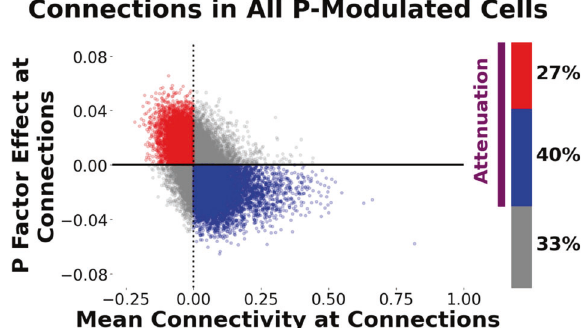
Fig. 4 Quadrant analysis demonstrating attenuating effects of the P factor on neurotypical functional-connectivity patterns. In the main NCA analysis, we identi fi ed 28 cells (i.e., sets of connections linking pairs of large-scale networks) that were signi fi cantly associated with the P factor. In a follow-up quadrant analysis, we placed these connections in one of four quadrants according to directionality of mean connectivity ( x axis) and directionality of P factor effects ( y axis); in the fi gure, each dot represents one connection. We found 67% of connections reside in quadrants corresponding to attenuating effects, i.e., quadrant 2 shown in red (negative mean connectivity, positive P factor effect) and quadrant 4 shown in blue (positive mean connectivity, negative P factor effect). Non-parametric permutation tests showed that this elevated proportion of attenuating P factor effects was highly unlikely to have arisen by chance (p PERMUTATION < effect) and quadrant 4 (positive neurotypical connectivity, negative P factor effect) — a pattern that re fl ects attenuation of neurotypical connectivity by the P factor. Permutation testing revealed that this elevated percentage of attenuating P factor effects is highly unlikely to have arisen by chance ( p PERMUTATION < 0.0002). We additionally conducted quadrant analysis on each of the 28 cells separately. We found a statistically signi fi cant proportion of attenuation (i.e., elevated counts of connections in quadrants 2 and 4) in 18 out of the 28 cells considered individually ( p PERMUTATION ’ s < 0.05).